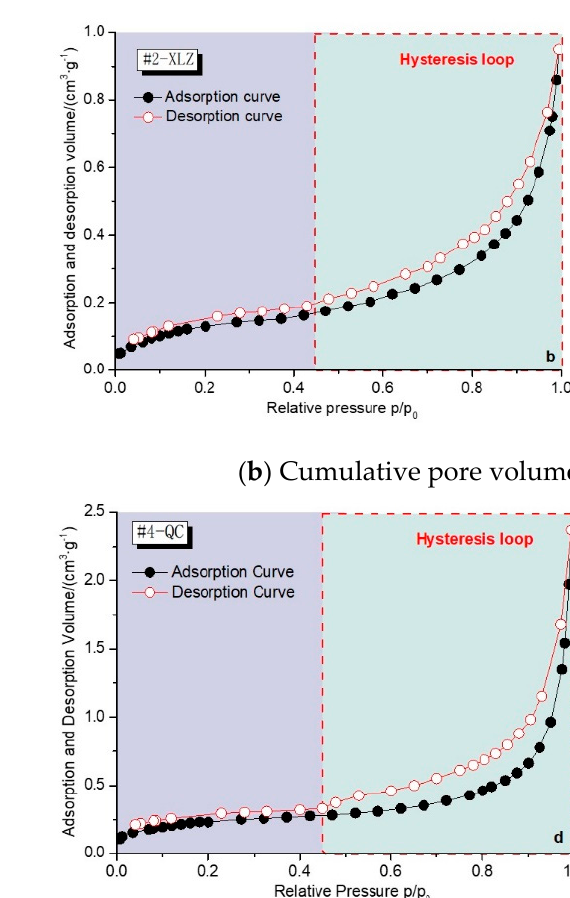
a#1 > a#4 > a#2 ≈ a#3 and b#1 > b#4 > b#2 ≈ b#3. That is to say, within this range, the pore